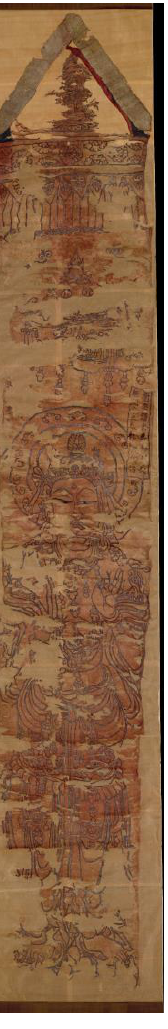
Figure 9. Long Banner (Stein Painting 217), 10th century CE, silver on woven damask red silk, H. 386.0 cm, W. 68.1 cm, 1919,0101,0.217, British Museum. © The Trustees of British Museum.